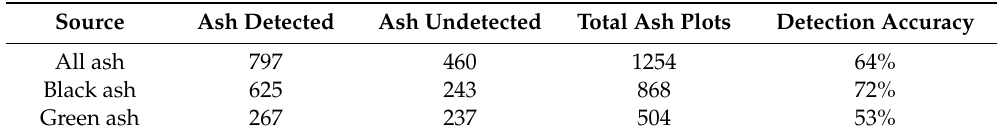
Table 6. Accuracy of ash species detection using Forest Inventory and Analysis data in Minnesota,